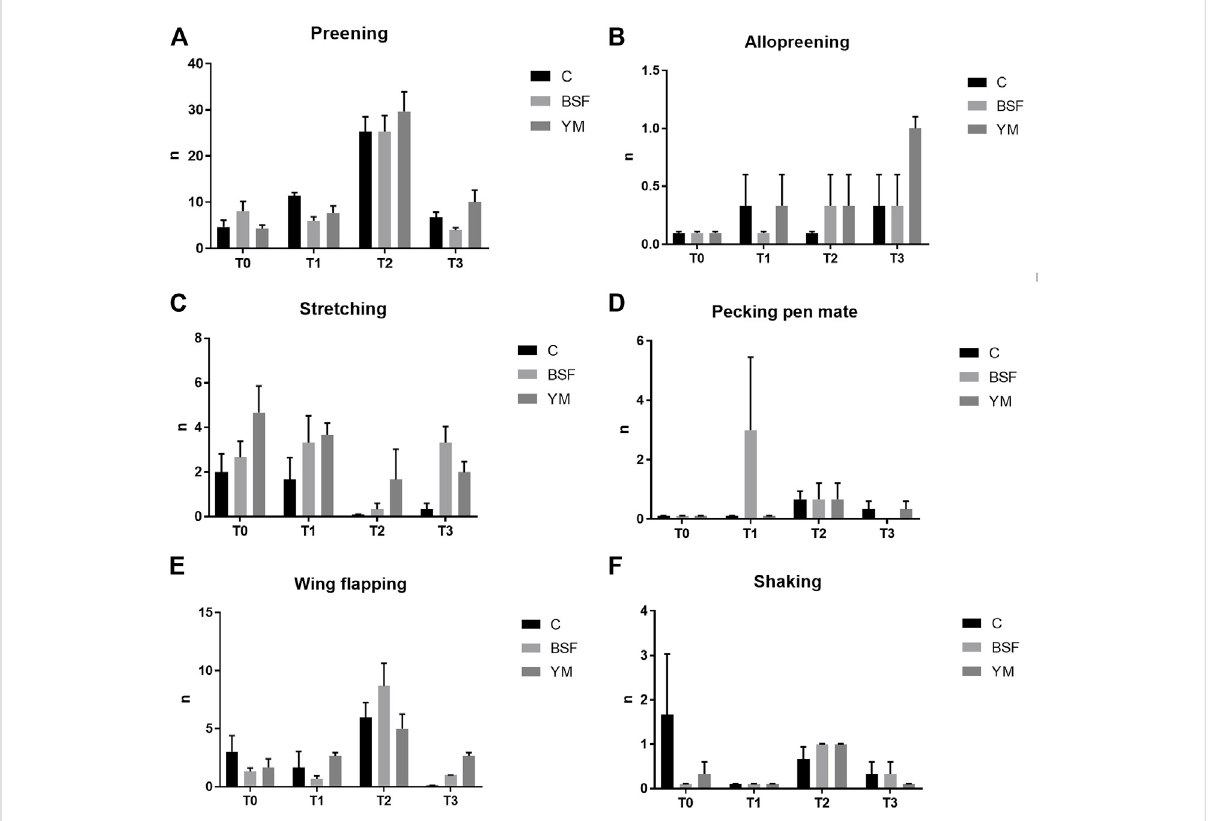
FIGURE 1 Frequency behaviours of the broiler chickens in the morning (diet*time interaction, p > 0.05). (A) Preening. (B) Allopreening. (C) Stretching. (D) Pecking pen mate. (E) Wing fl apping. (F) Shaking. C = control group; BSF = C diet + black soldier fl y live larvae; YM = C diet + yellow mealworm live larvae. T0 = day 0; T1 = day 11; T2 = day 22; T3 = day